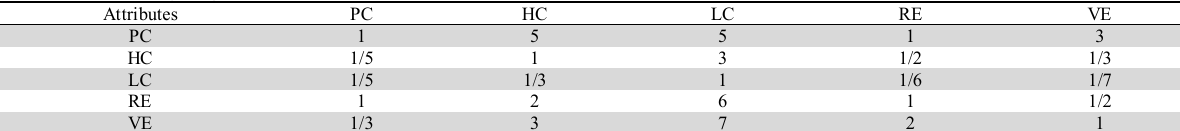
The results of judgment Attributes